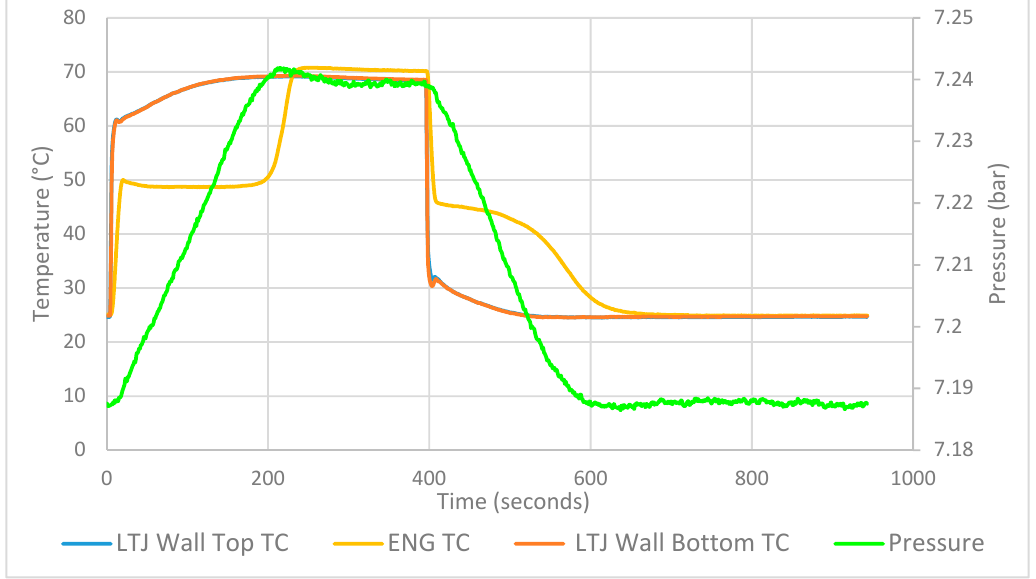
Figure A1. Raw results from the LTJ experiment, TC stands for thermocouple. Both LTJ wall thermocouples can be seen to show the same results, which shows effective design.